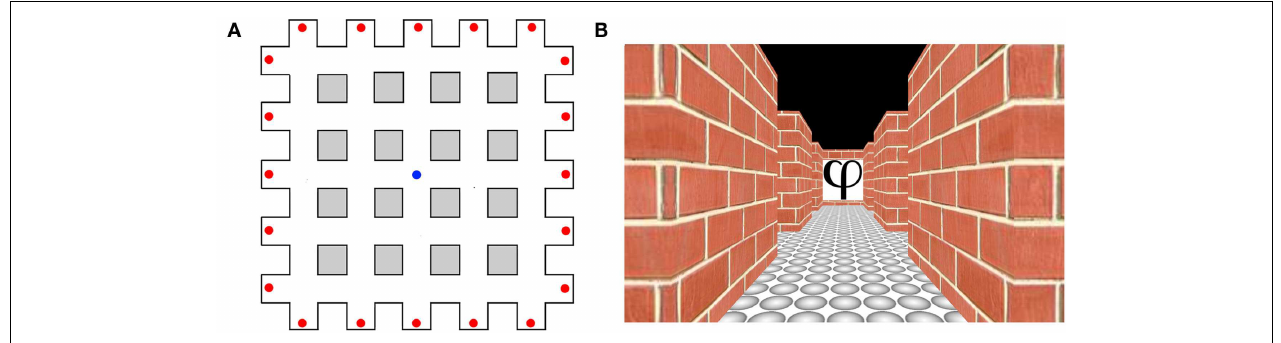
represent the locations of the abstract symbols that acted as orientation landmarks.The blue dot represents the starting location of each learning trial. (B) An example of a single image viewed by participants during the test